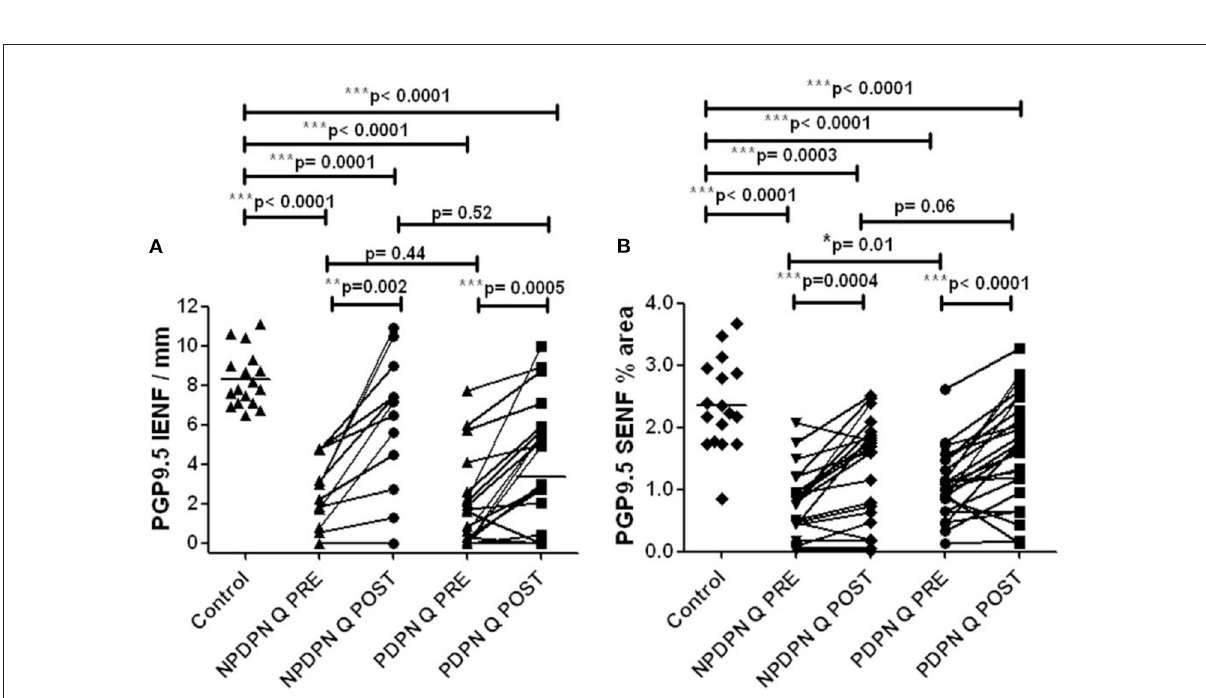
FIGURE6 PGP9.5 immunohistochemistry in 50 µ m sections from skin biopsies in non–painful (NPDPN Q + SOC) and painful (PDPN Q + SOC) Diabetic Peripheral Neuropathy following Capsaicin 8% patch Qutenza (Q) treatment. Intra–epidermal (IENF/mm, A) and sub–epidermal fiber density (SENF, % area, B) in NPDPN and PDPN. (A) IENFs in NPDPN Q + SOC and PDPN Q + SOC at baseline (Q PRE) and statistically non–significant difference before (Q PRE, p = 0. 44; Mann–Whitney test; n = 24 NPDPN Q + SOC and n = 25 PDPN Q + SOC) or 3 months after treatment (Q POST, p = 0.52, Mann–Whitney test). Statistically significant difference between control group and baseline (Q PRE), and after treatment (Q POST) (Mann–Whitney test). (B) SENFs in NPDPN Q + SOC and PDPN Q + SOC at baseline (Q PRE) and statistically significant difference before (Q PRE, * p = 0. 01; Mann–Whitney test; n = 24 NPDPN Q + SOC and n = 25 PDPN Q + SOC) but not 3 months after treatment (Q POST, p = 0.06, Mann–Whitney test). Statistically significant decreases between control group and baseline (Q PRE) but less significance after treatment (Q POST) (Mann–Whitney test) in NPDPN Q + SOC but not PDPN Q + SOC. ***Highly